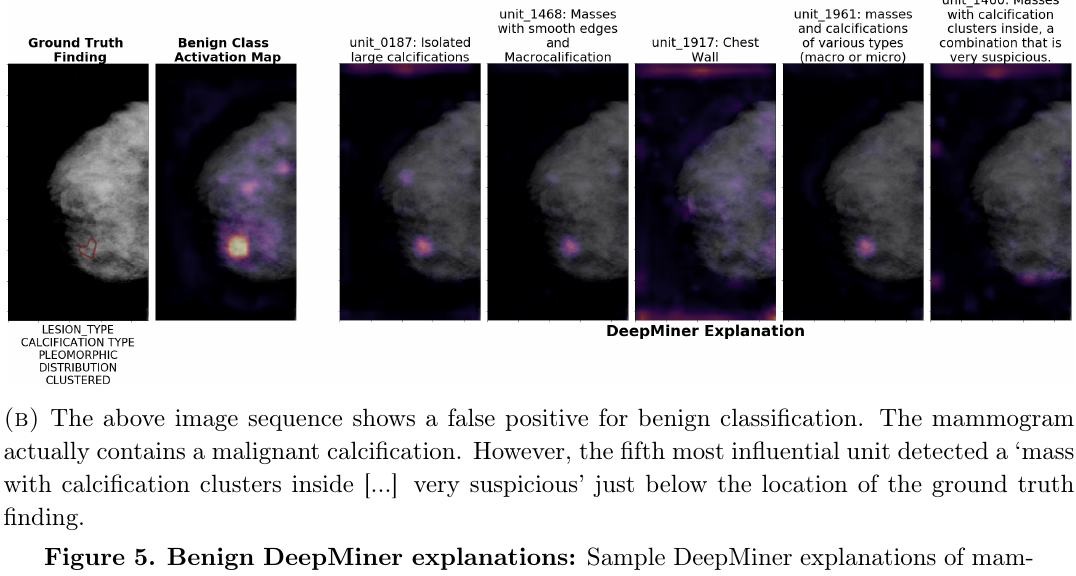
Figure 5. Benign DeepMiner explanations: Sample DeepMiner explanations of mam- mograms classified as benign. Best viewed in